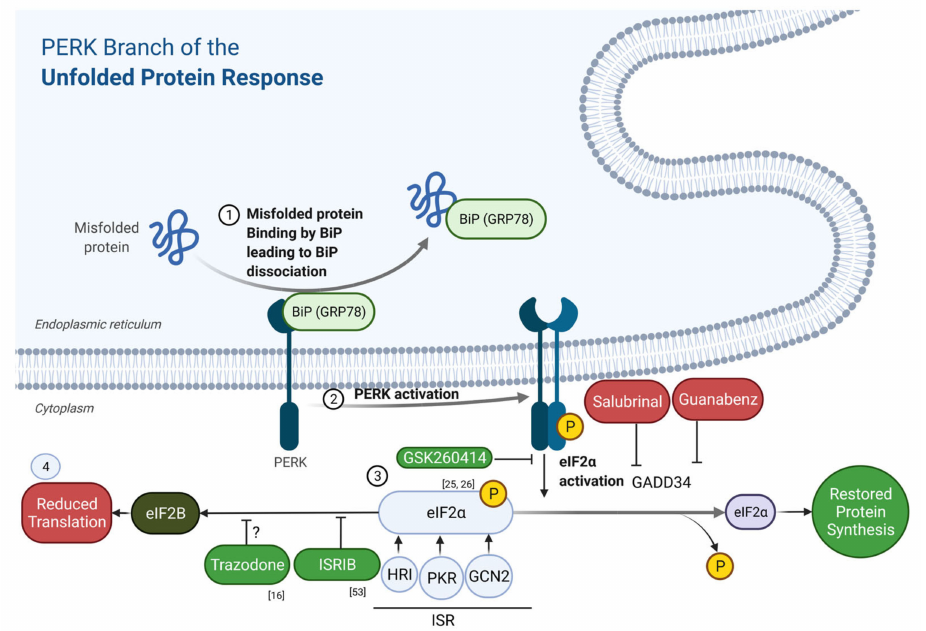
Figure 2. Schematic showing points of action of drugs and experimental compounds targeting the PERK branch of the UPR and ISR. (1) The chaperone protein known as binding immunoglobulin protein (BiP) binds to misfolded proteins, resulting in (2) phosphorylation of PERK. PERK activation, in turn, leads to (3) phosphorylation of eIF2 α , which reduces protein translation (4) via by preventing nucleotide exchange by eIF2B needed for initiation of translation. GSK260414 inhibits PERK phospho- rylation; ISRIB prevents eIF2B binding by p-eIF2 α , and trazodone also acts downstream of p-eIF2 α by restoring global protein synthesis rates. Intervention at all of these steps provides